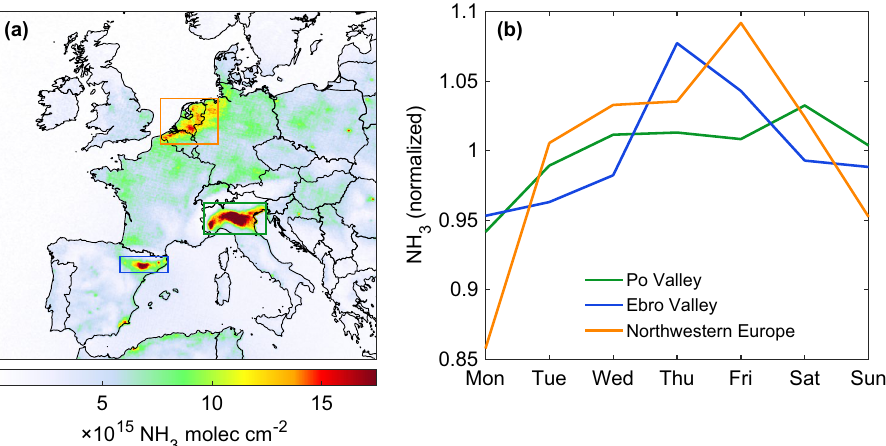
− 2 ) over Europe based on IASI-A (2008–2019),